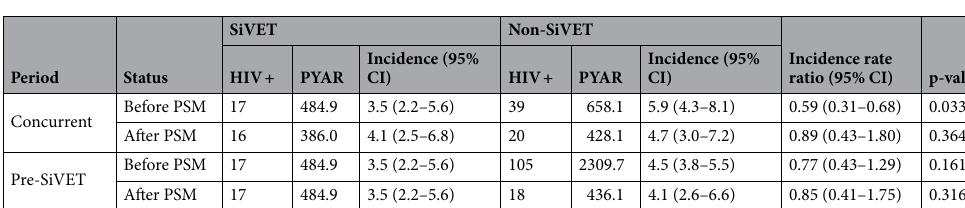
Table 3. HIV incidence by study period before and after propensity score matching. PSM propensity score matching, CI confidence interval, PYAR person years at